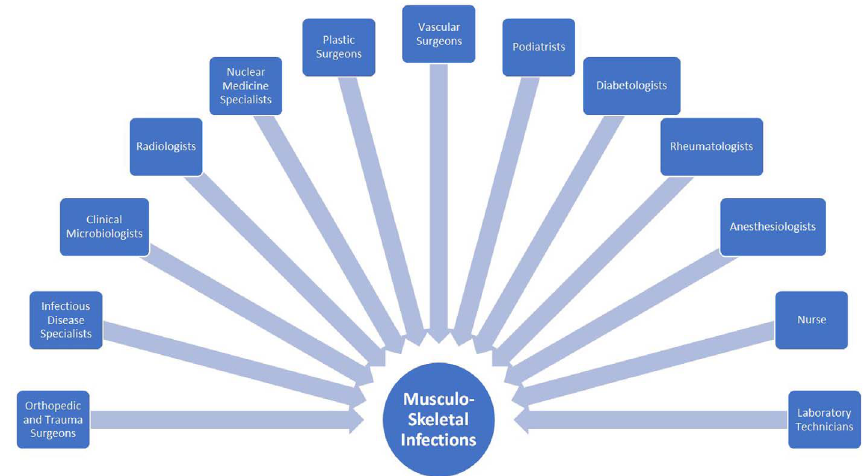
Figure 1. An (incomplete) list of healthcare professionals involved in managing musculoskeletal